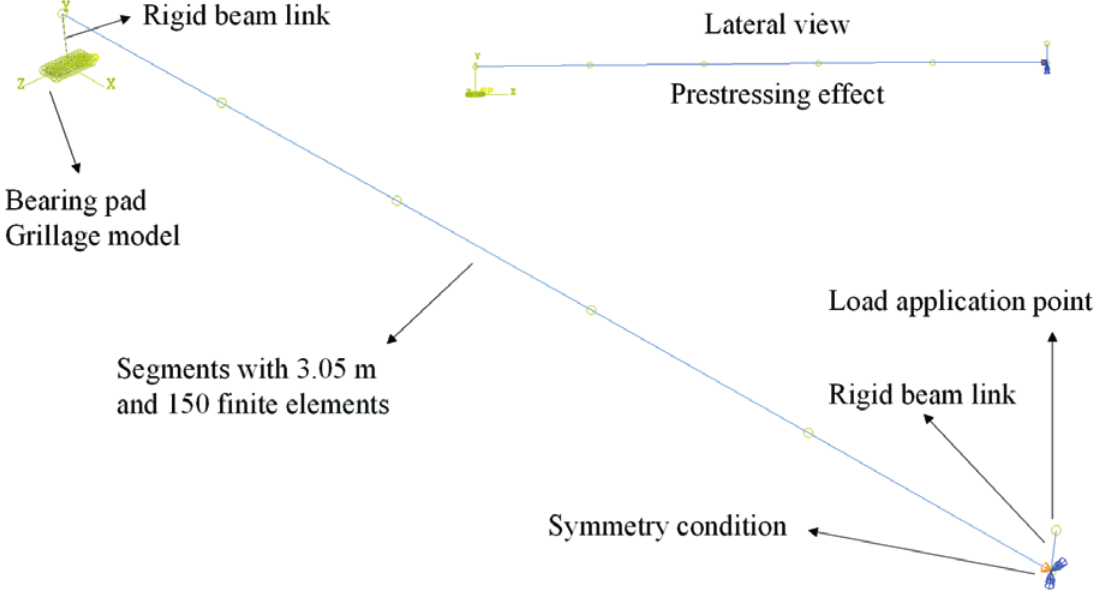
Schematic representation of the numerical